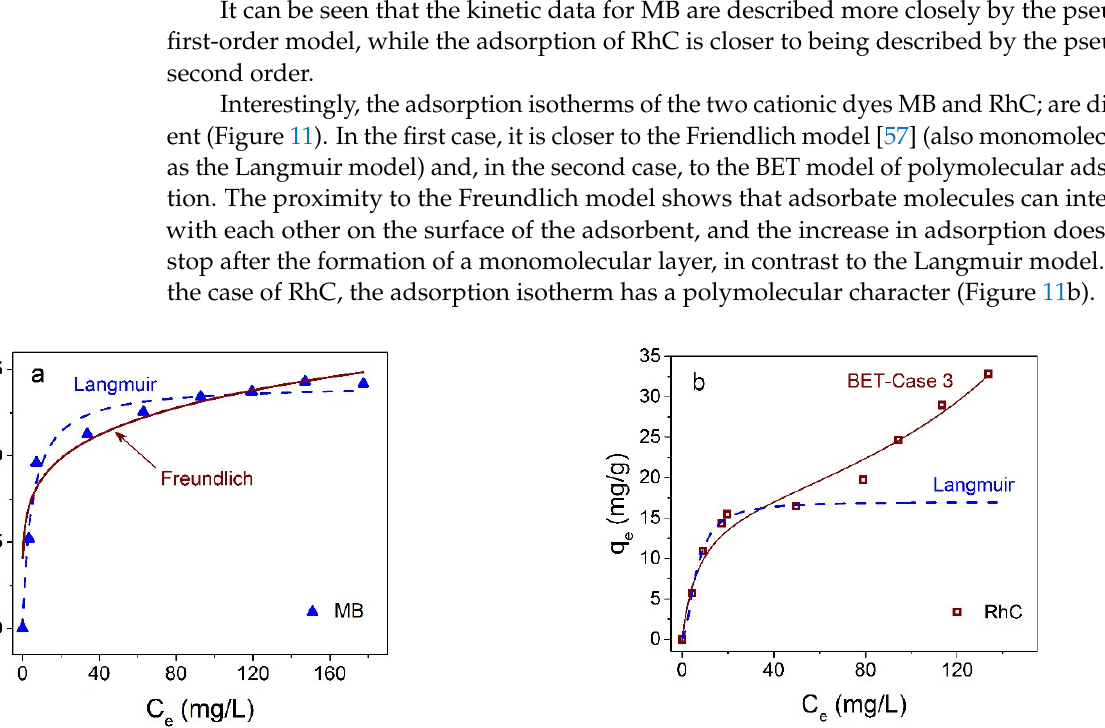
Table 3. Parameters of the best nonlinear fitting of the experimental adsorption data for Fe 3 O 4 @C NPs to the pseudo-first- and pseudo-second-order kinetic models.